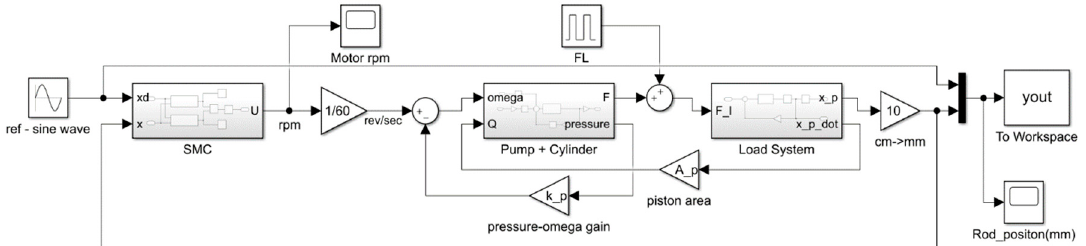
Figure 10. Control simulation with Matlab Simulink. Table 3. T he parameters of the cylinder and pump.